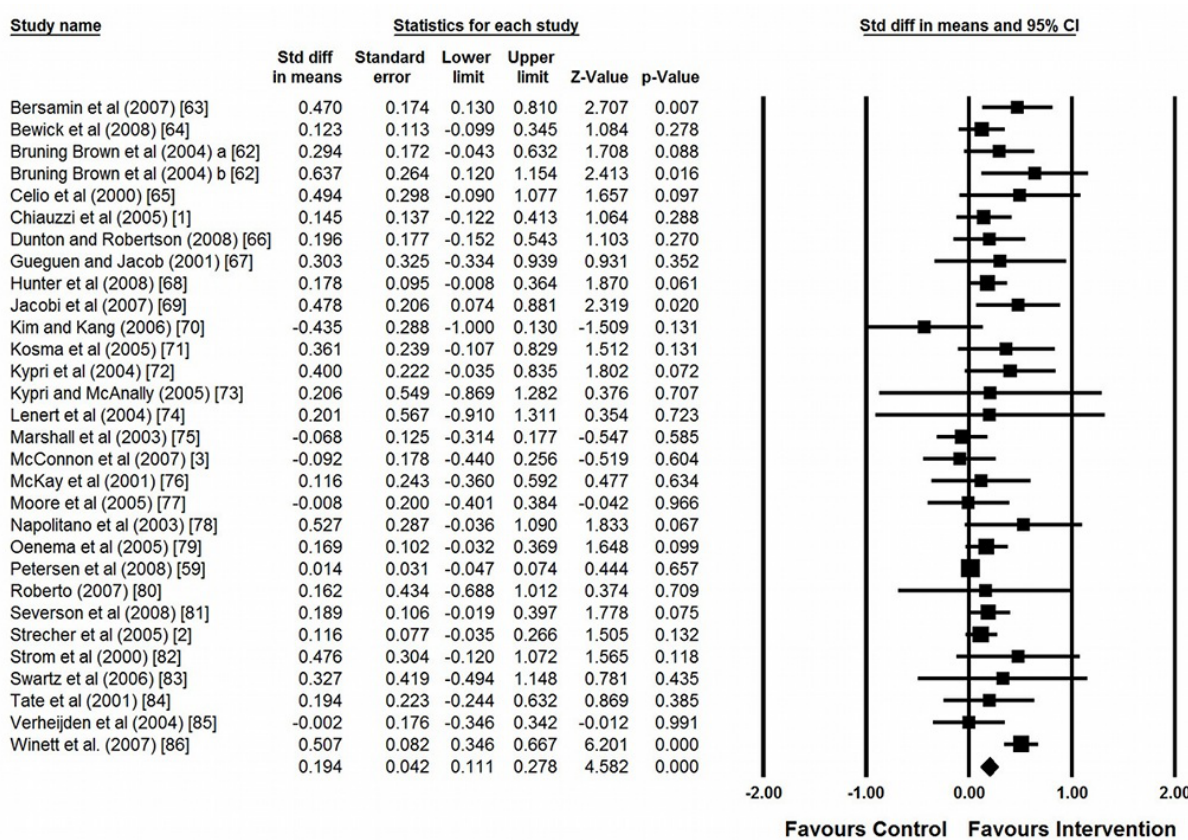
Figure 3. Forrest plot